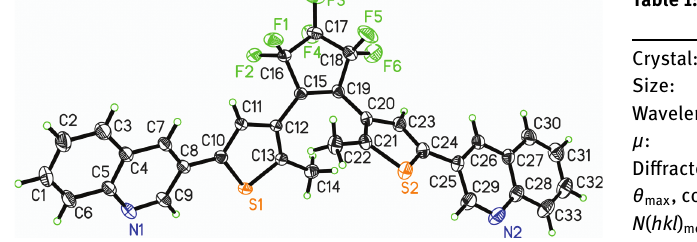
Table 1: Data collection and